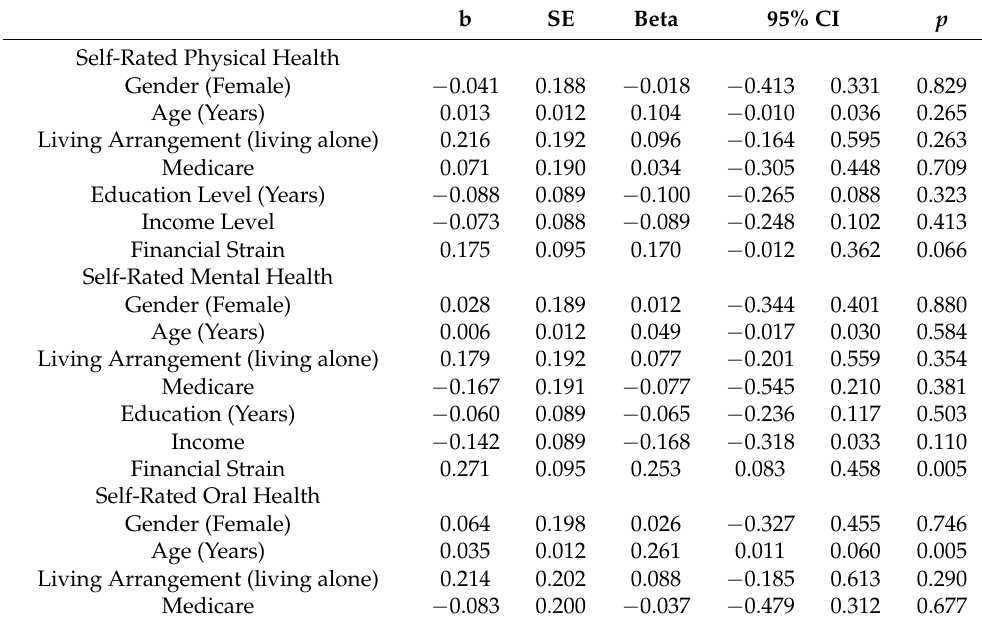
Table 3. Summary of three linear regression models with poor self-rated physical, mental, and oral health as